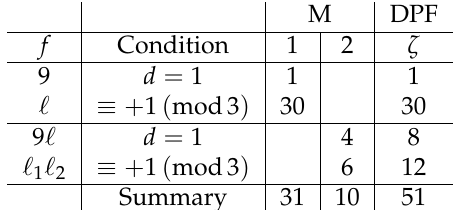
Table 4. Cyclic cubic discriminants in the range 0 < d L = f 2 < 10